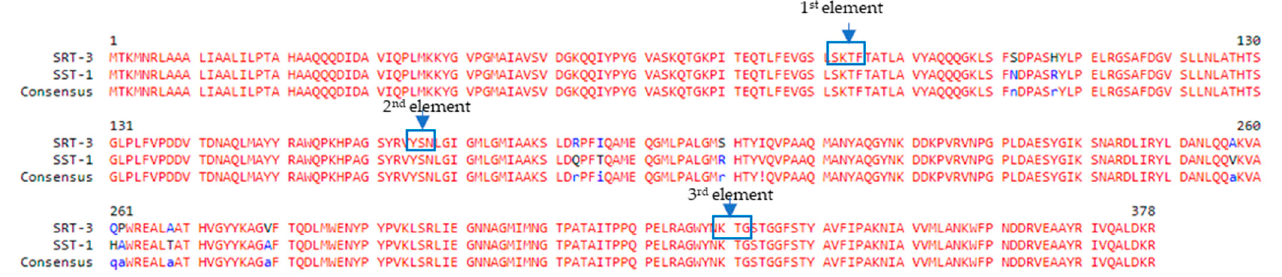
Figure 1. Amino acid sequence alignment of SRT-3 and SST-1 β -lactamases.